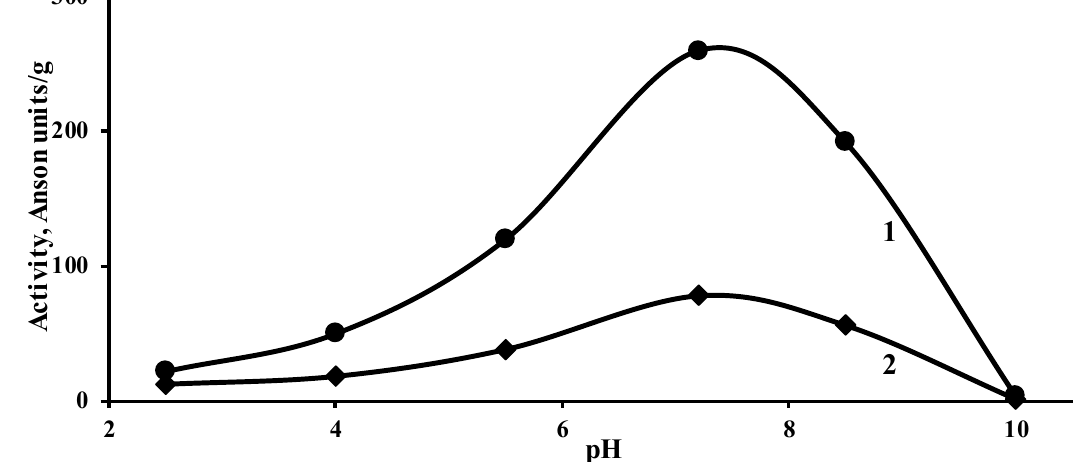
Figure 1. Dependence of EP Novo Bate WB ( 1 ) and EP Zime SB ( 2 ) activity on pH of medium (temperature 20 °C; duration of action 20 min).